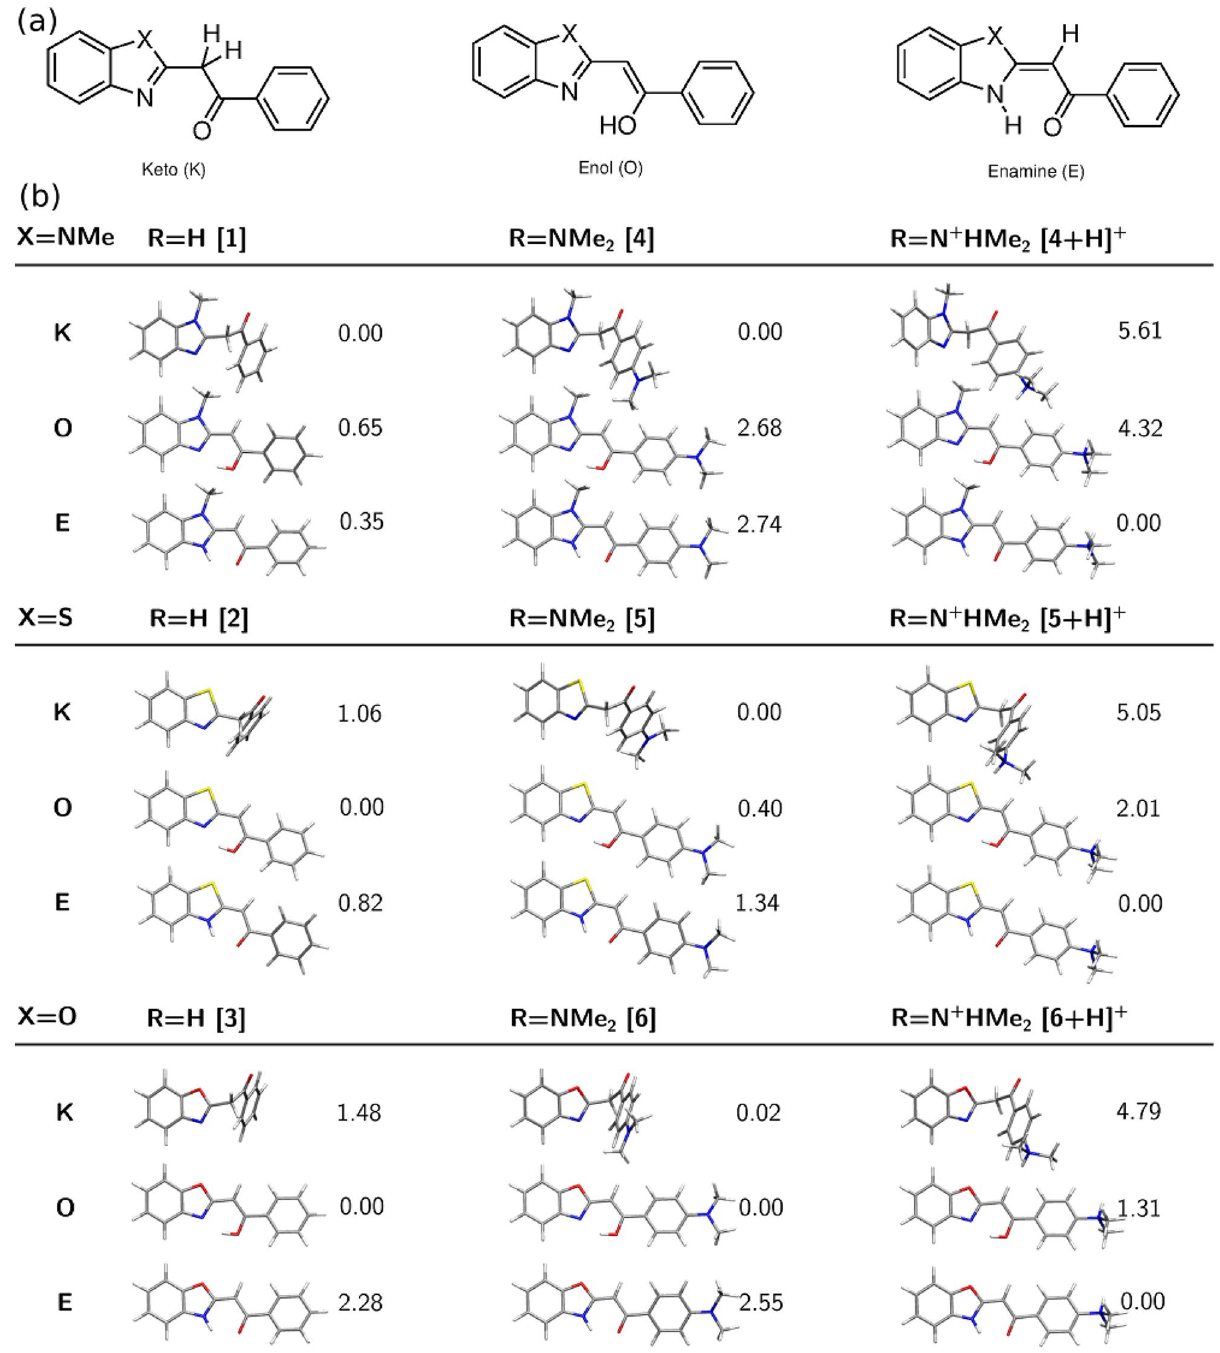
Figure 2. Tautomeric equilibria for neutral 1 – 6 (panel ( a ): K, O and E denote keto, enol and enamine form, respectively) and dimethyloamine-protonated counterparts of 4 – 6 . ω B97X-D/6-311++G(d,p) relative energies in panel ( b ) are given in